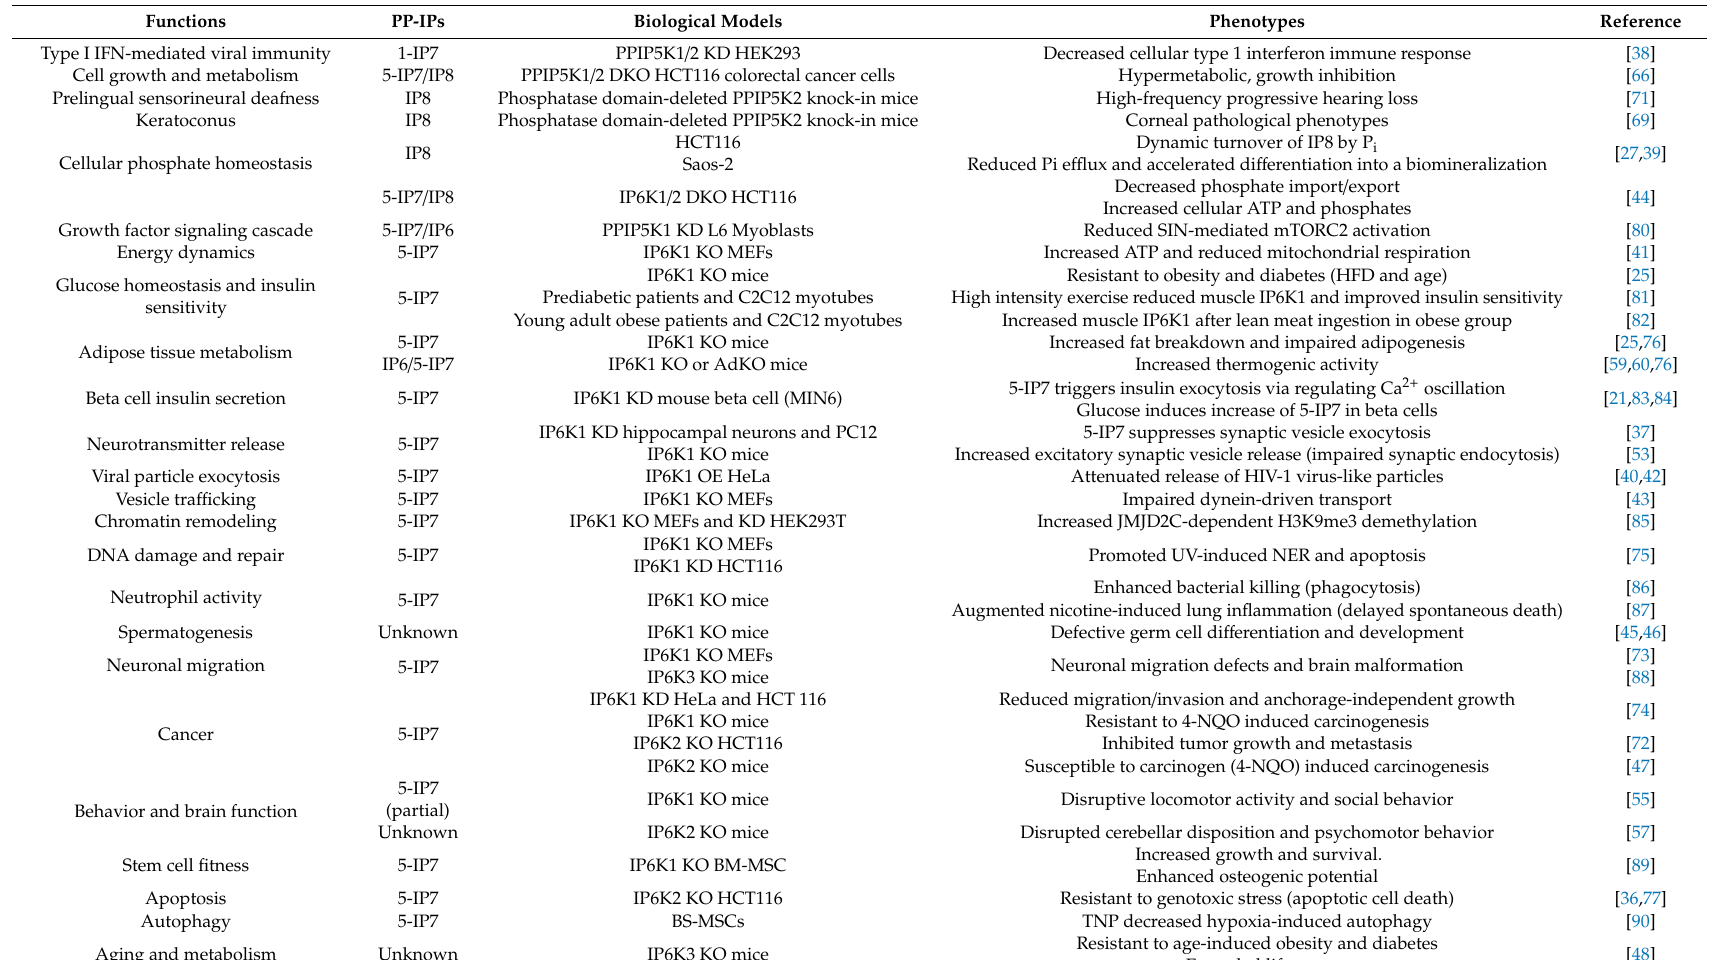
Table 1. Physiologic functions of inositol